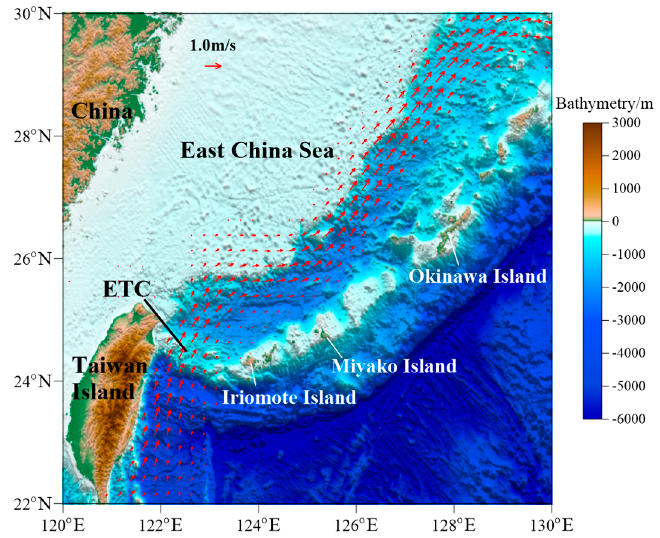
Figure 1. Topographic map (unit: m) in the East China Sea (ECS) with climatological geostrophic current vectors (value > 0.15 m/s; red arrows), which are derived from the multi-year averaged altimeter data from 1993 to 2016, superimposed.